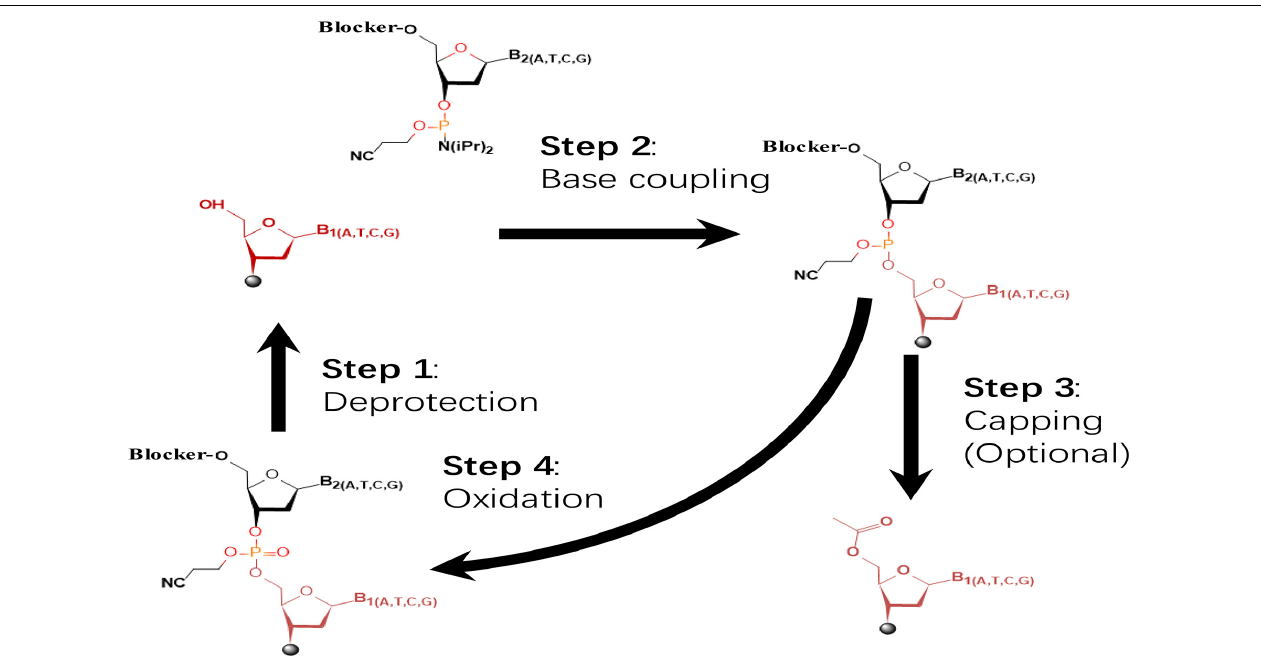
FIGURE 1 | The dominating four-step, phosphoramidite chemistry widely applied in commercial oligo synthesizers. The initial nucleoside(s) is tethered to specific substrate via its 3 (cid:48) hydroxyl. The synthetic cycle involves four steps of deprotection, base coupling, capping, and oxidation. Synthesis proceeds in direction of 3 (cid:48) to 5 (cid:48)